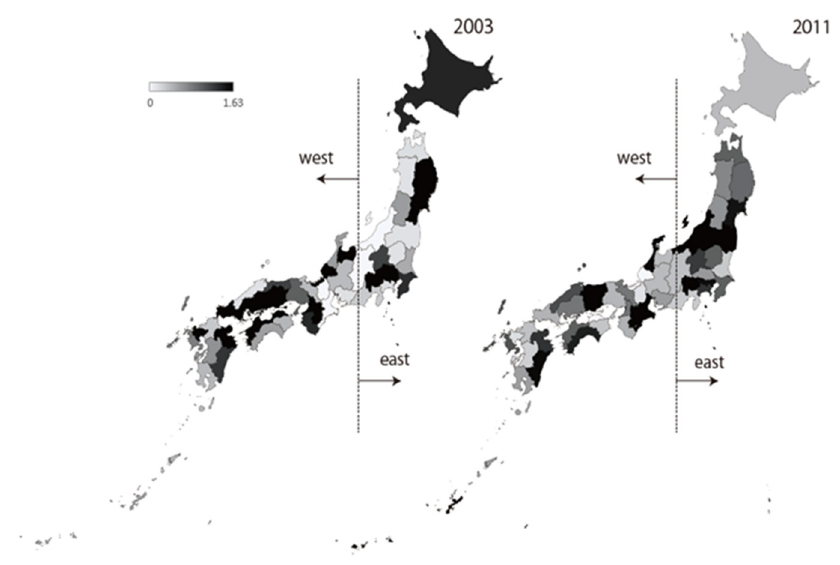
Figure 3. Reported case of MDRP infection per sentinel, NESID 2003 and 2011.